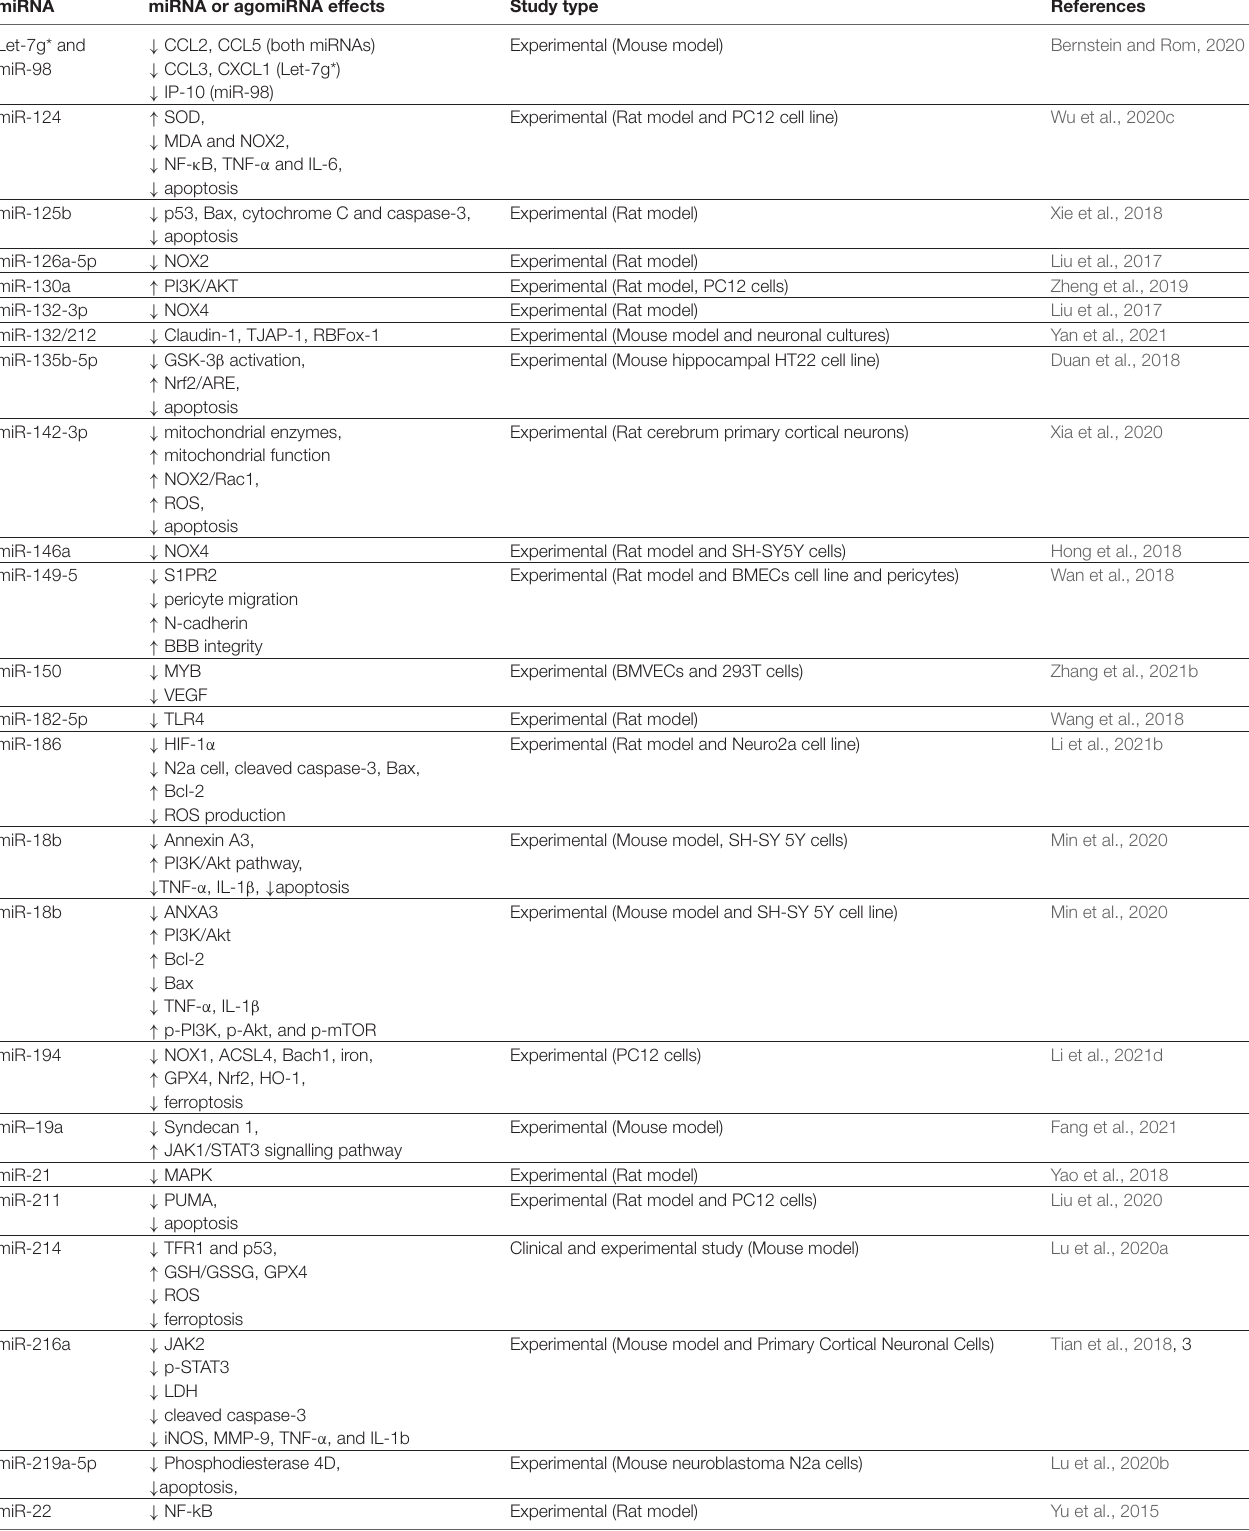
TABLE 2 | Down-regulated miRNAs in cerebral I/R